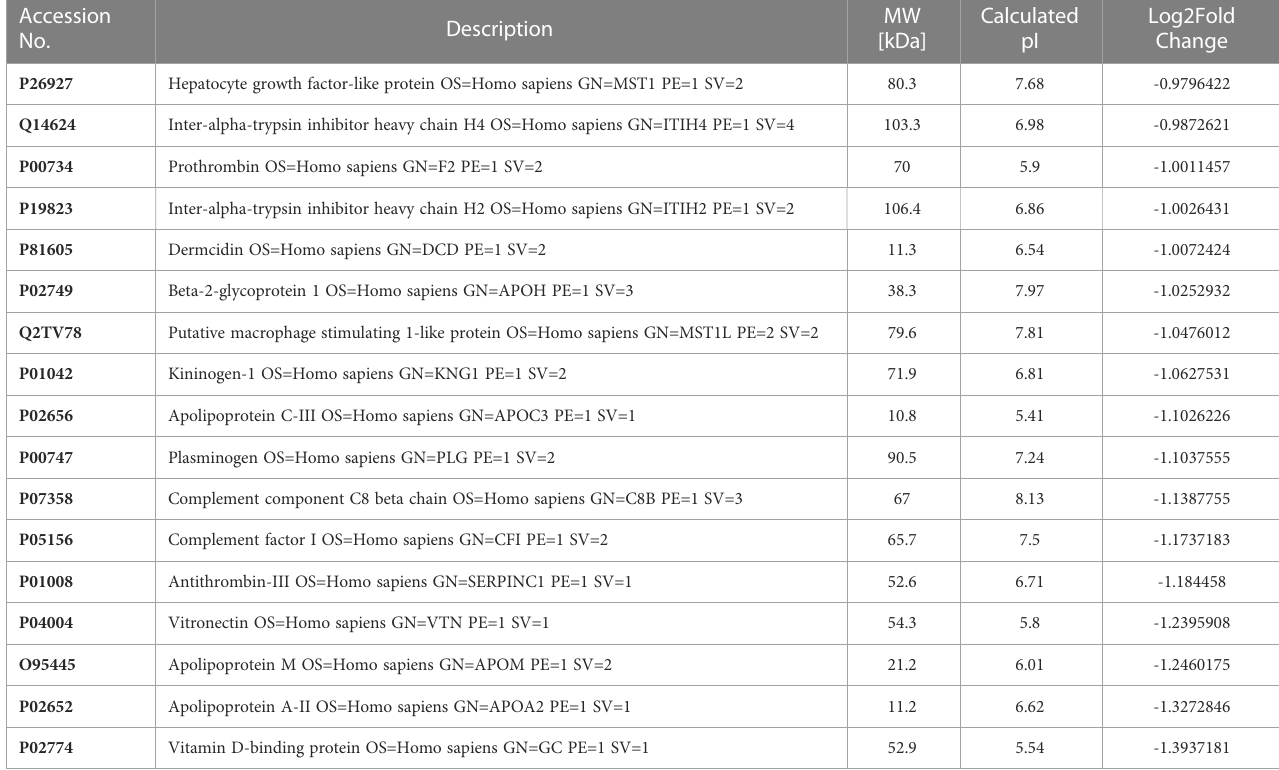
Figure 4E) as well as in ACLF progression to AKI vs no progression to AKI, p-value ≤ 0.0001; Figure